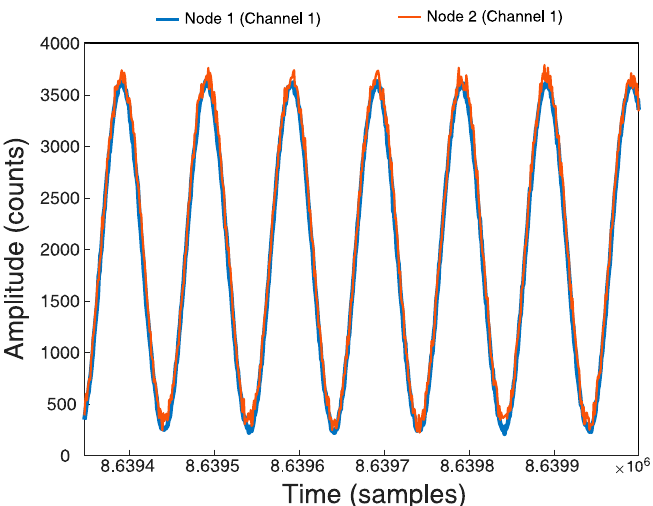
Figure 18. Final signal in Register 24 h with Sinchro.